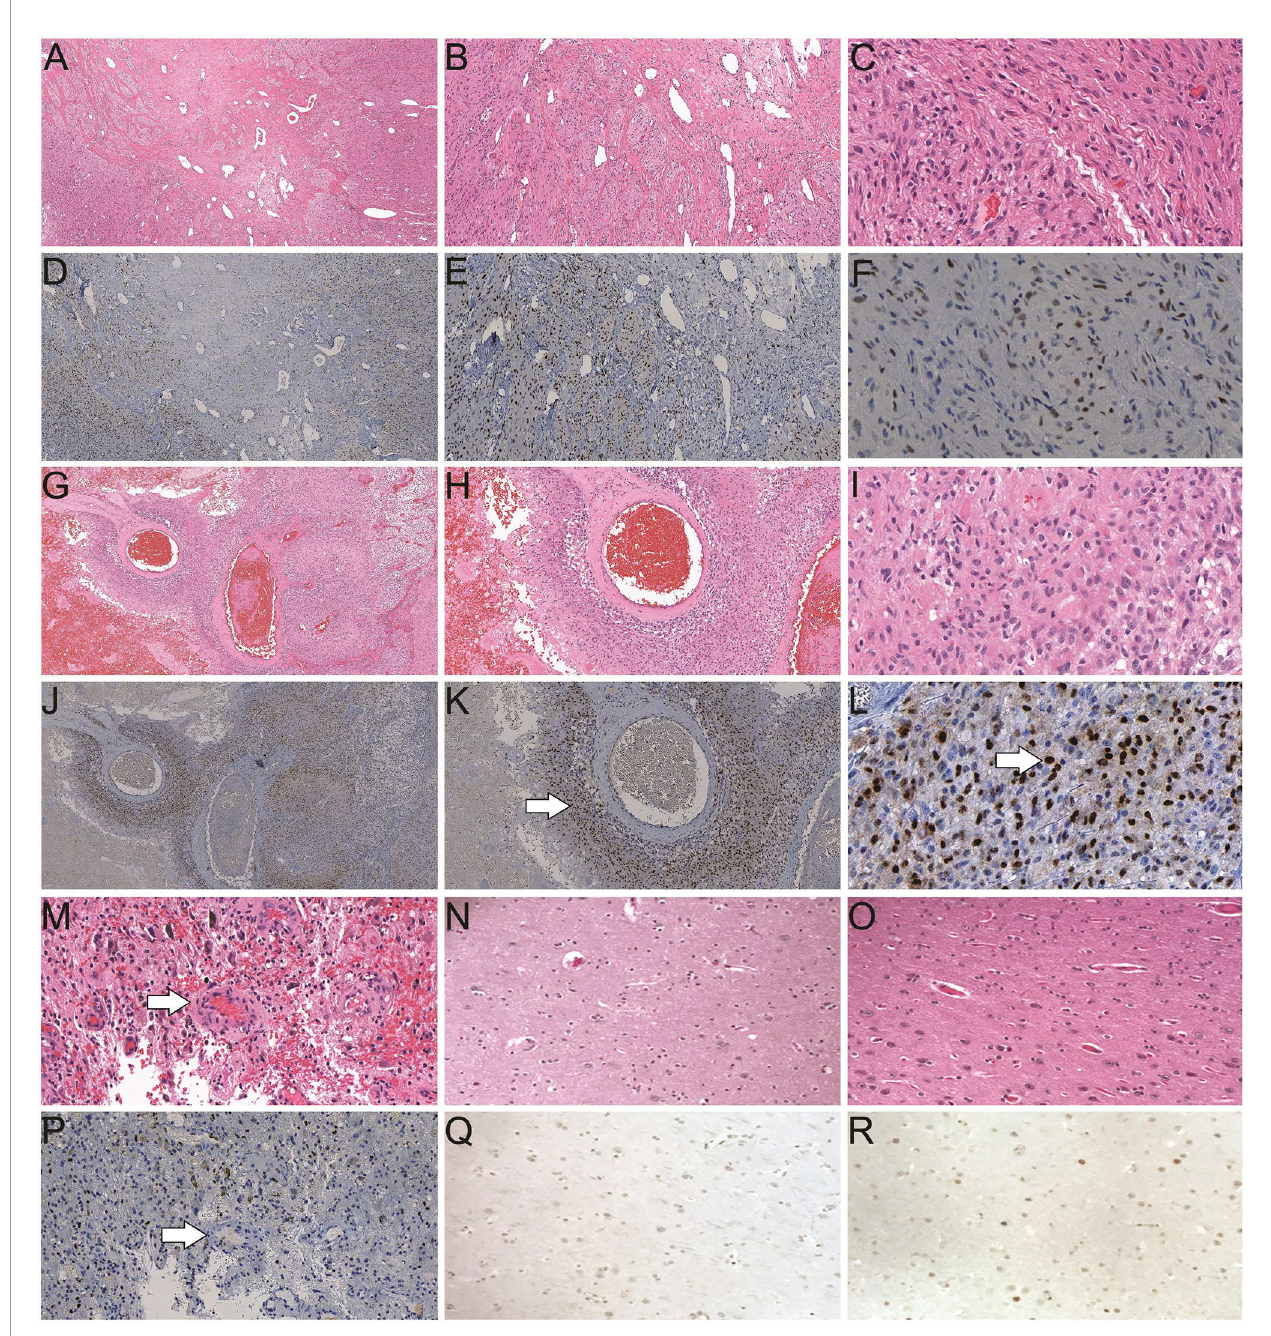
FIGURE 1 | Histological studies of androgen receptor (AR) expression in human brain/GBM tissue. (A – C) H&E staining of a GBM slide from a male patient (40×, 100× and 400× magni fi cation, respectively). (D – F) Positive AR expression (brown) in a GBM slide from the same patient as A (40×, 100× and 400× magni fi cation, respectively). (G – I) H&E staining of a GBM slide from a female patient (40×, 100× and 400× magni fi cation, respectively). (J – L) AR staining in a GBM slide from the same patient as G (40×, 100× and 400× magni fi cation, respectively). Enriched AR positive cells at peri-vascular area are best shown in K (arrow). Majority of AR staining (brown) is in nuclei in a subset of the cells (arrow in L ). (M) H&E staining of a GBM specimen showing the endothelial proliferation of the vessels (arrow). (P) AR staining of the GBM specimen from the same patient as M. (N) H&E staining of a normal human brain autopsy specimen. (Q) Negative AR staining of the normal brain autopsy specimen from the same patient as N, at 400× magni fi cation. (O) H&E staining and (R) scattered weakly positive nuclear staining of AR in a temporal lobectomy surgical specimen from a patient with epilepsy, at 400× magni fi